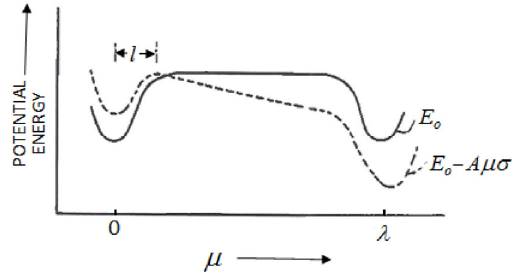
Fig. 3 Influence of applied stress on the potential energy curve of a moving dislocation. Adapted from